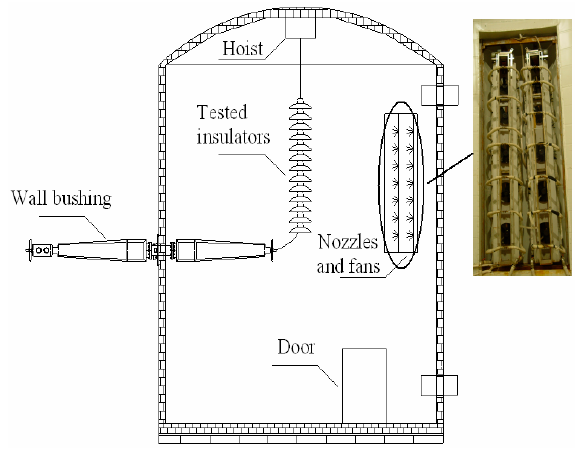
Figure 1. Multi-functional artificial climate chamber.